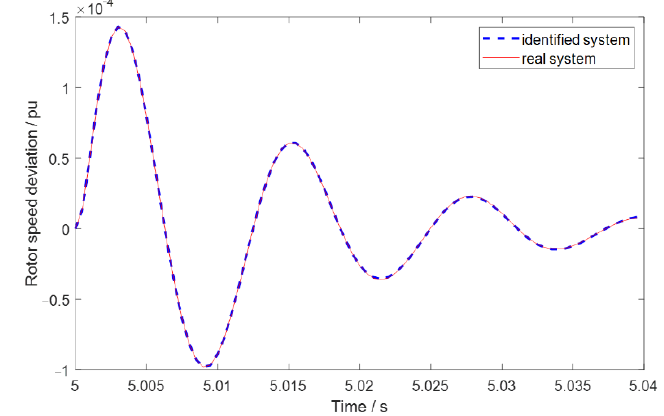
Figure 8. The identified curve of active power control loop.